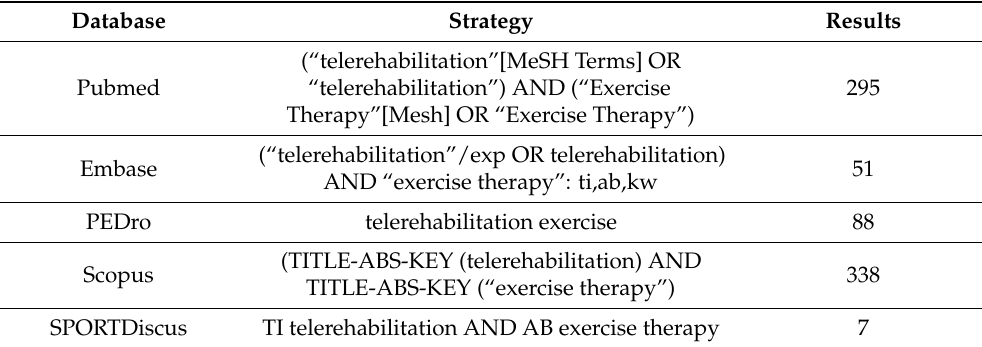
Table 1. Research strategy in databases.